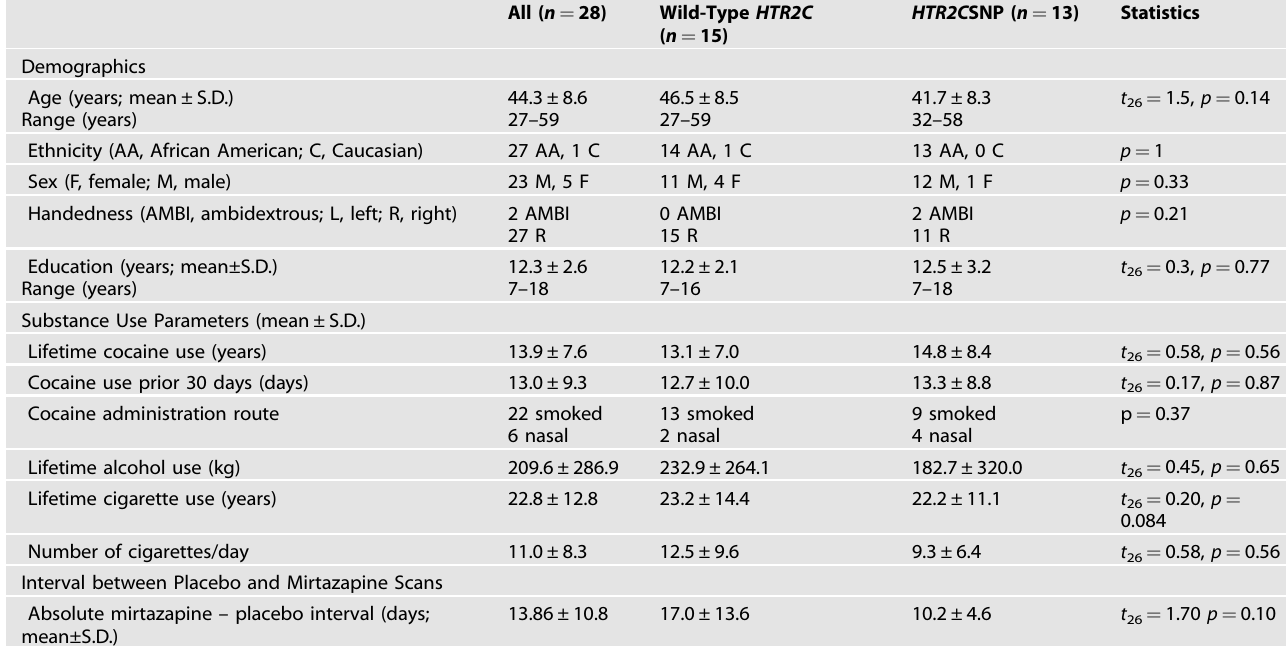
Table 1. Demographics, substance use parameters and in-scanner behavior under placebo and mirtazapine